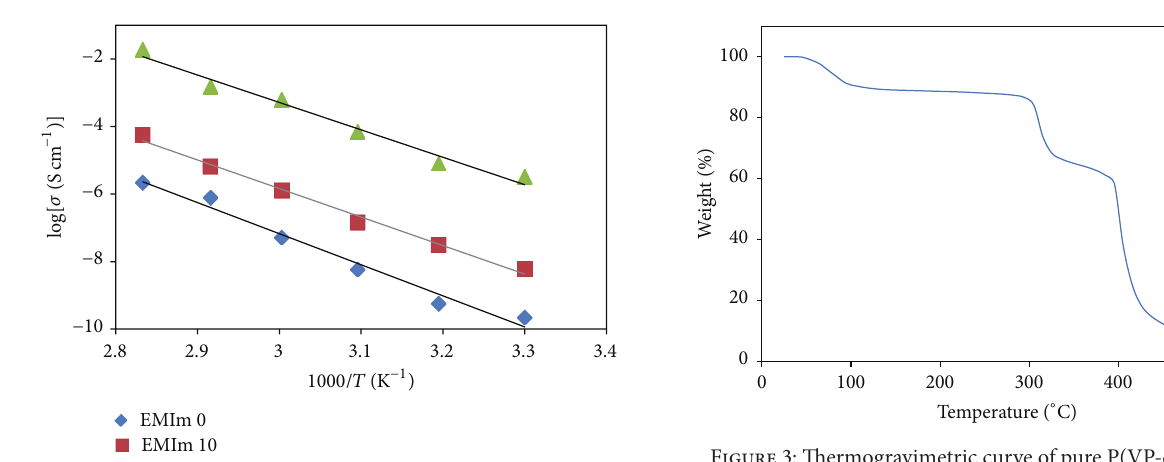
Figure 3: Thermogravimetric curve of pure P(VP-co-VAc).